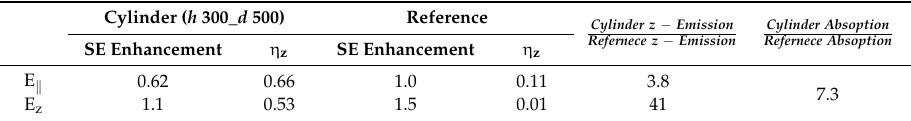
Table 1. The volume average spontaneous emission (SE) enhancements of parallel (E (cid:107) ) and perpendicular (E z ) dipole sources at a wavelength of 660 nm and the absorption enhancement at a wavelength of 980 nm. The UC material absorbs near-infrared (NIR) light with a wavelength of 980 nm and emits visible light with a wavelength of 660 nm. SE enhancements in an array of nanocylinders on a gold substrate and those in the reference structure are compared. SE enhancements in Table 1, the averaged SE enhancements, are calculated by integrating the values over the whole nanocylinder volume. The output efficiency η z is defined as the ratio between the upward-directional emitted power and the total emitter